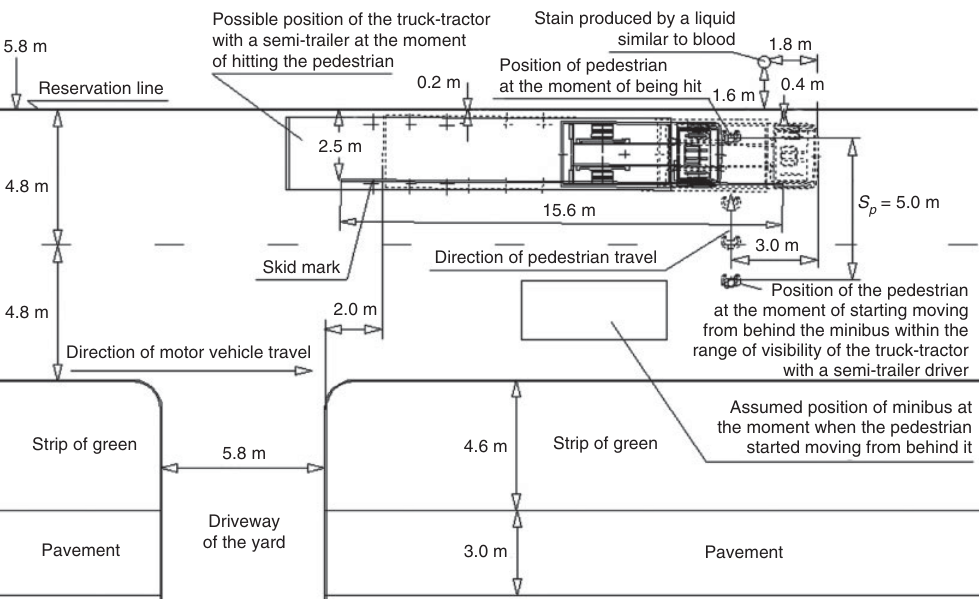
Fig. 9. The diagram of the traffic accident scene depicting the travel path of the pedestrian from the moment of appearing from behind the minibus, driving along the first lane of the road, until the moment the pedestrian has reached the hitting location, and the possible position of the truck-tractor with a semi-trailer at the moment of hitting the